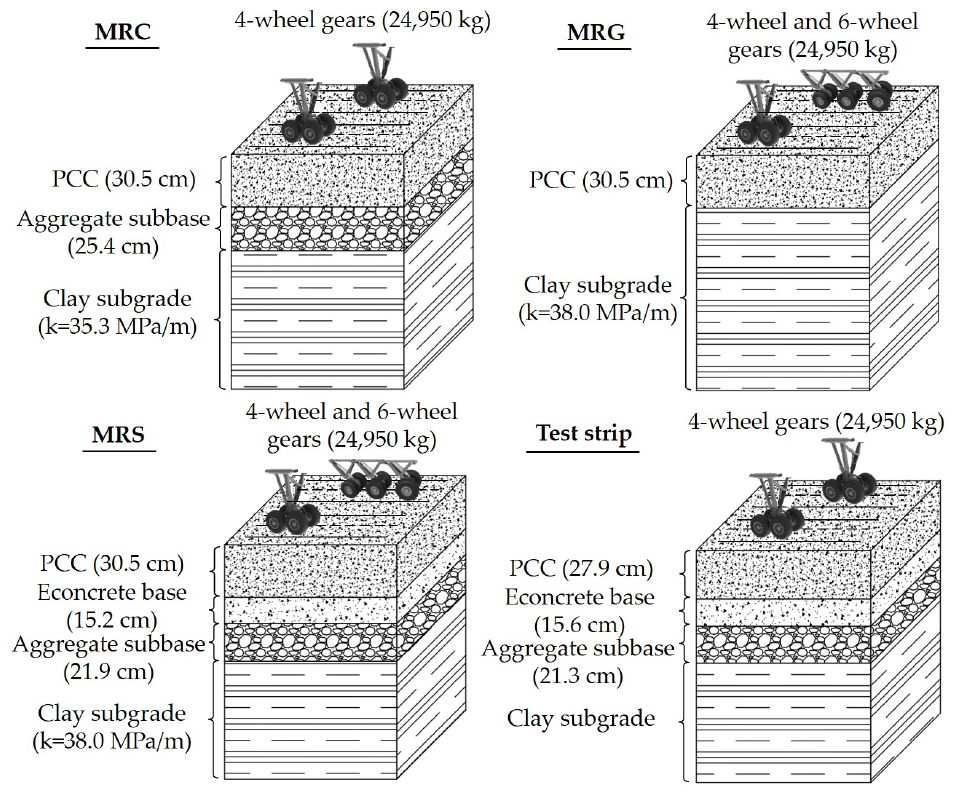
Figure 3. The pavement structure and loading method for the NAPTF CC2 test items.